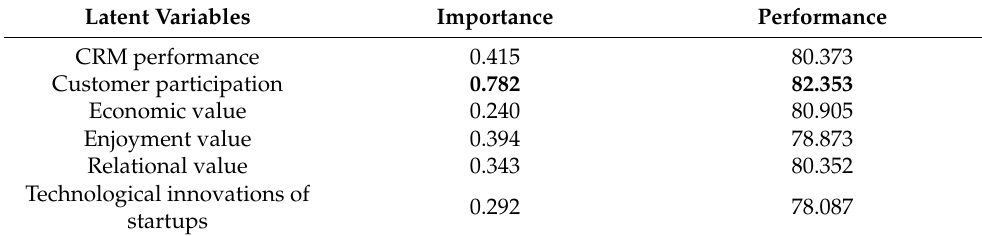
Table 7. Importance-performance map